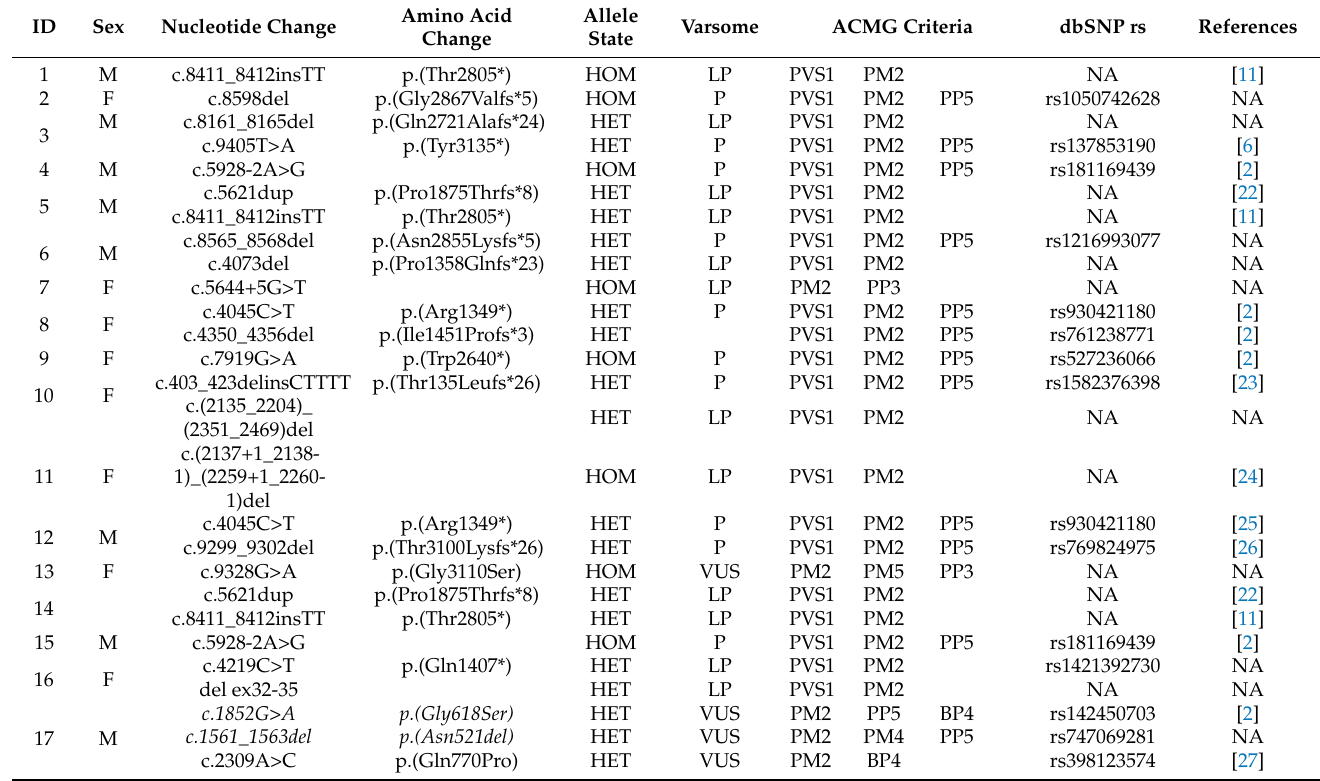
Table 1. Molecular Genetic Data of EYS patients.